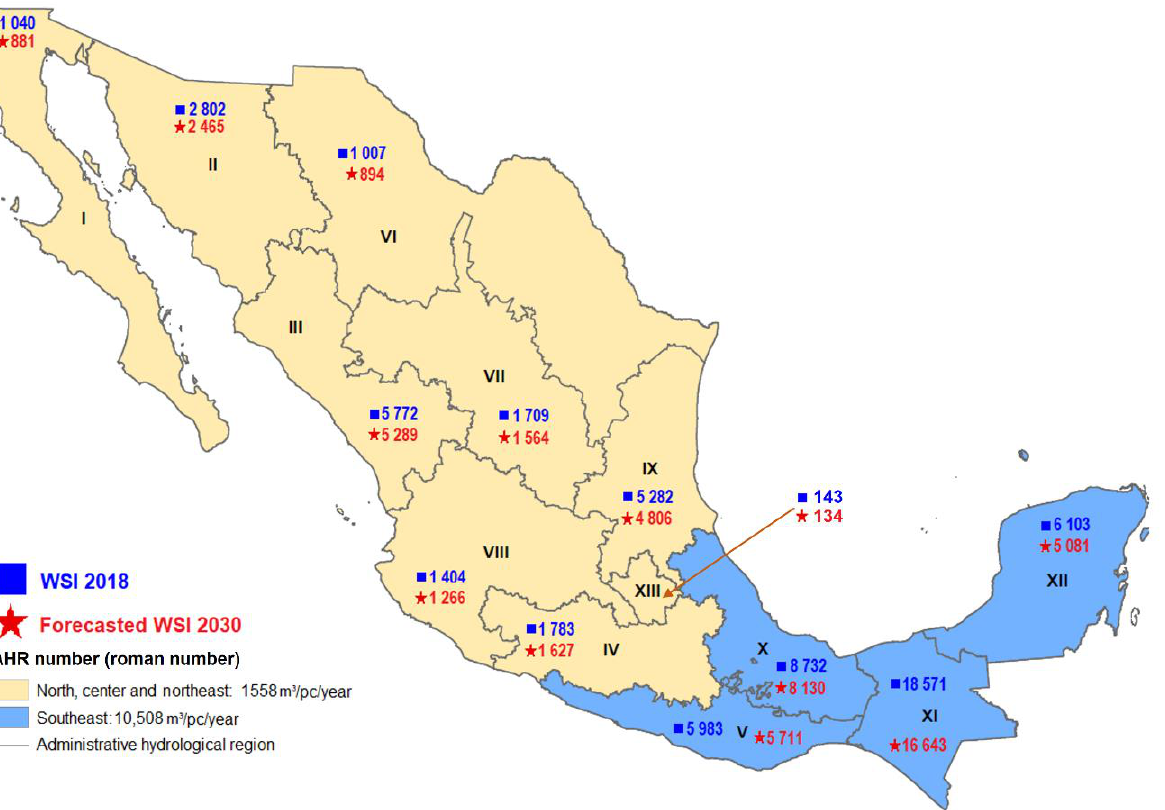
Table 1. Water scarcity-level classification in accordance with the Water Stress Indicator.